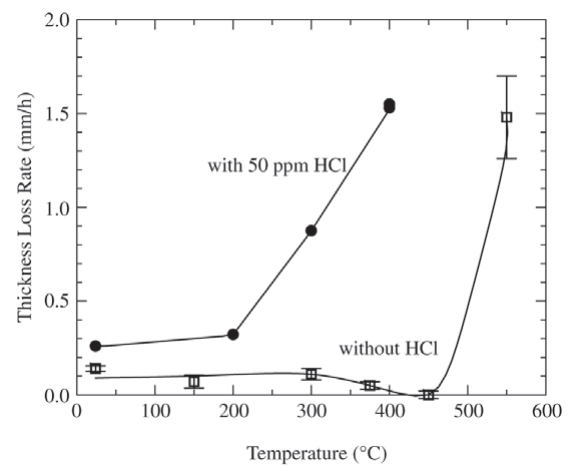
Figure 8. Effect of HCl dosage on the maximum wastage rate at 300 °C.